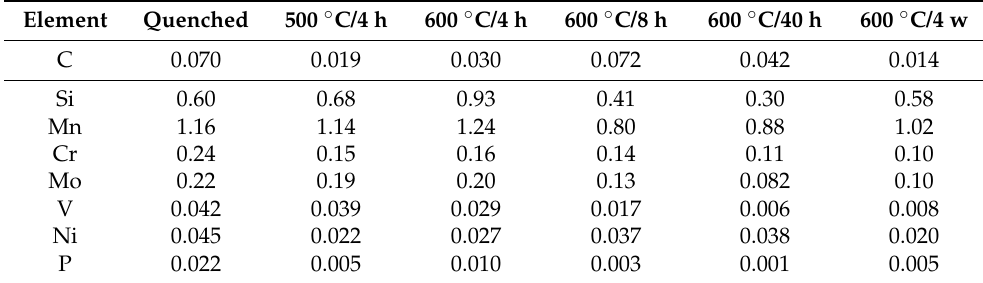
Table 2. Matrix composition (at%) of the six conditions of the material from APT (after removing the carbides in the reconstructions).